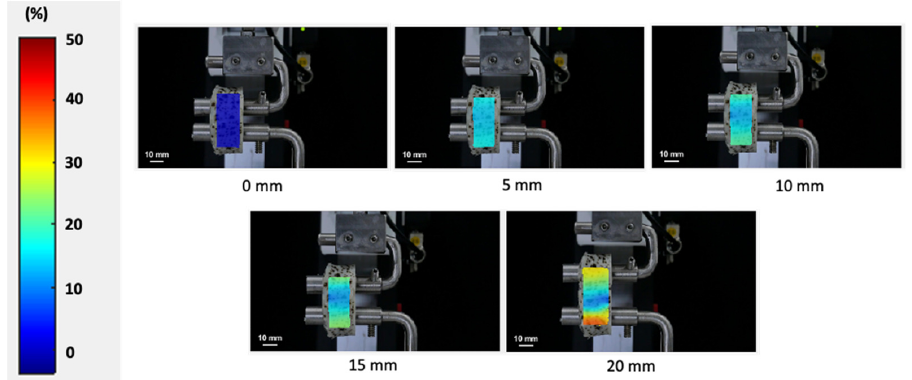
Figure 4. Contour plots of the strain component for surimi gel during the ring tensile test to the failure point.